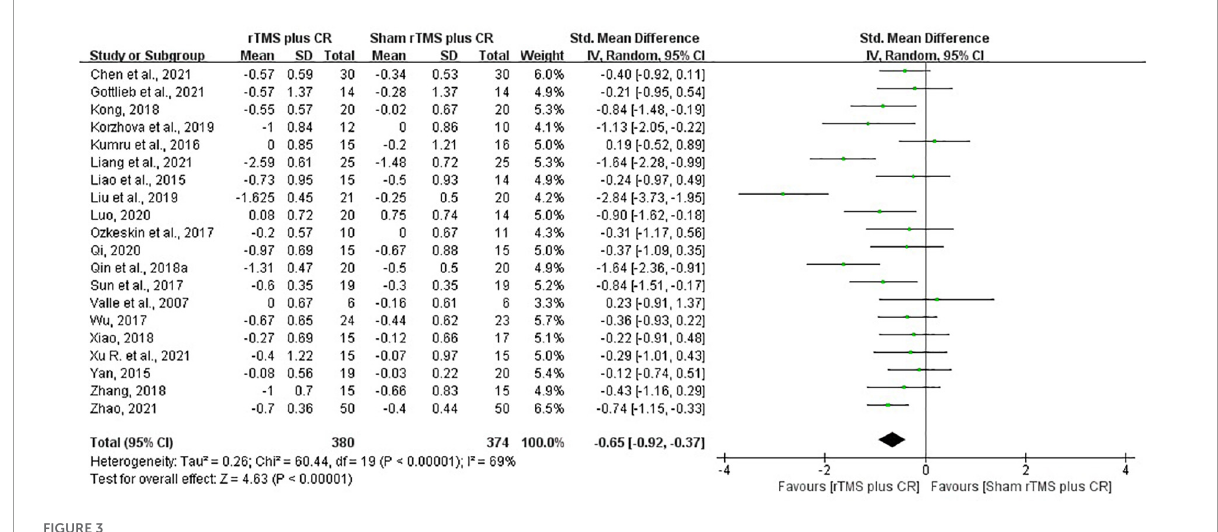
FIGURE3 The forest plot of MAS in comparison of rTMS plus CR versus sham rTMS plus CR.